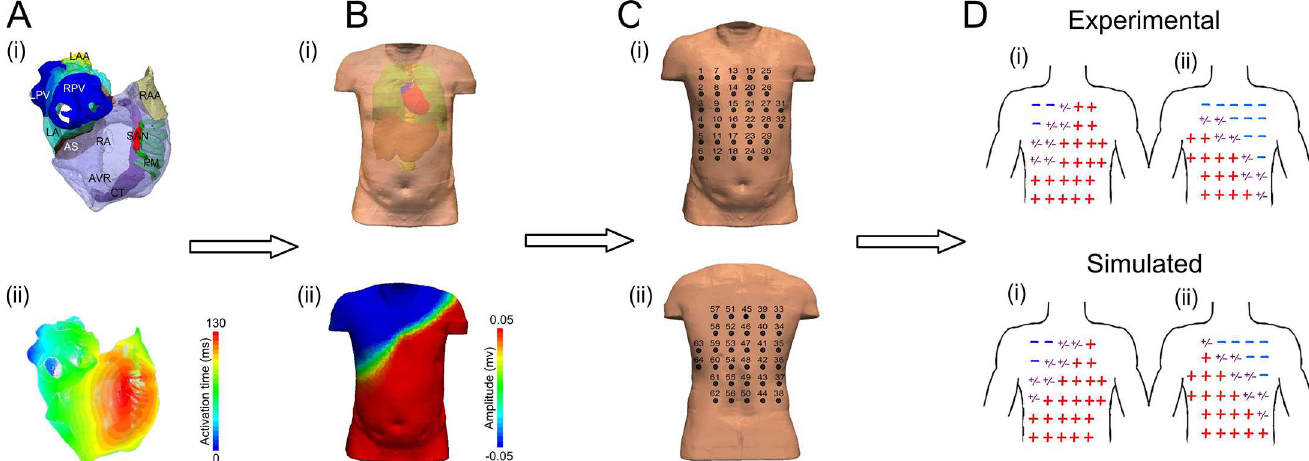
Fig 1. Models and procedure used to develop the algorithm. Illustration of atria (A) and torso (B) models used in the study to simulate re-entry and ectopic activity in the atria. (C) Electrode positionsused to simulate the 64-leadECG. (D) Simulatedanterior (i) and posterior (ii) polaritymap, as comparedto experimental data, validatingthe 3D atria-torso